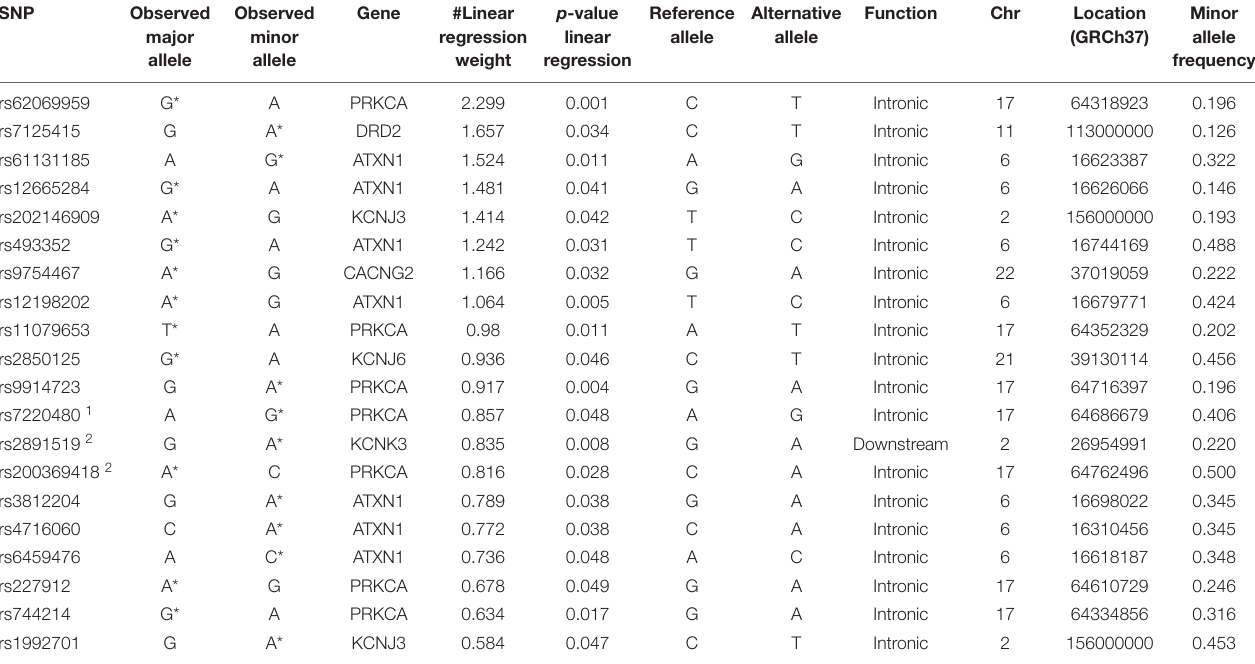
TABLE 2 | Genetic variants and risk alleles with regression coefficients included in the determination of polygenic risk score for prediction of chronic post-surgical pain. SNP Observed